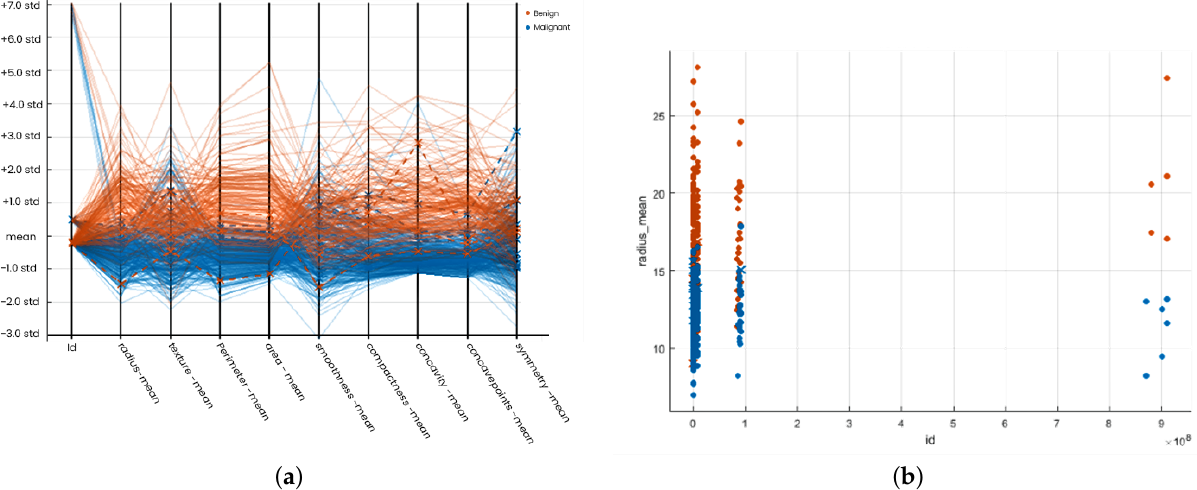
Figure 6. Results Plot Support Vector Machine. ( a ) Parallel co-ordination of SVM; ( b ) Scattered plot of